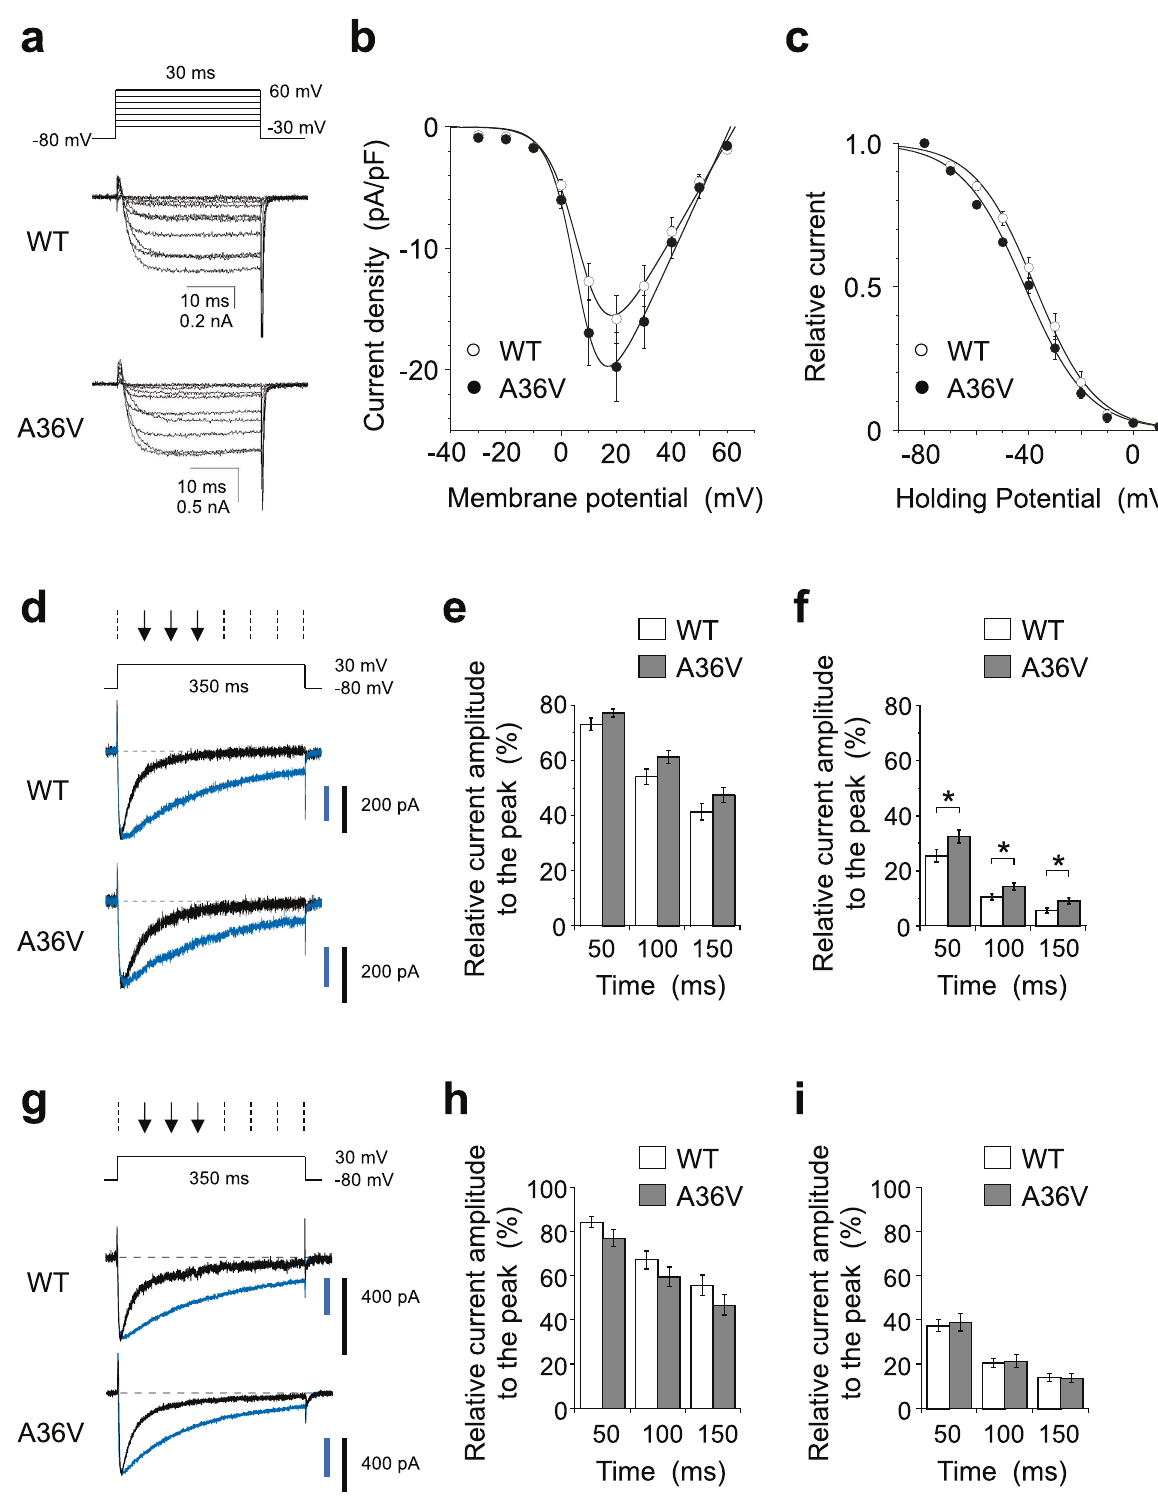
[54]. These splicing isoform-speci fi c observations suggest that the presence of the same Ca v 1.2 mutation in separate isoforms leads to distinct outcomes. The present study showed that the A36V mutation, when carried by the short neuronal isoform, inhibits CDI, suggesting